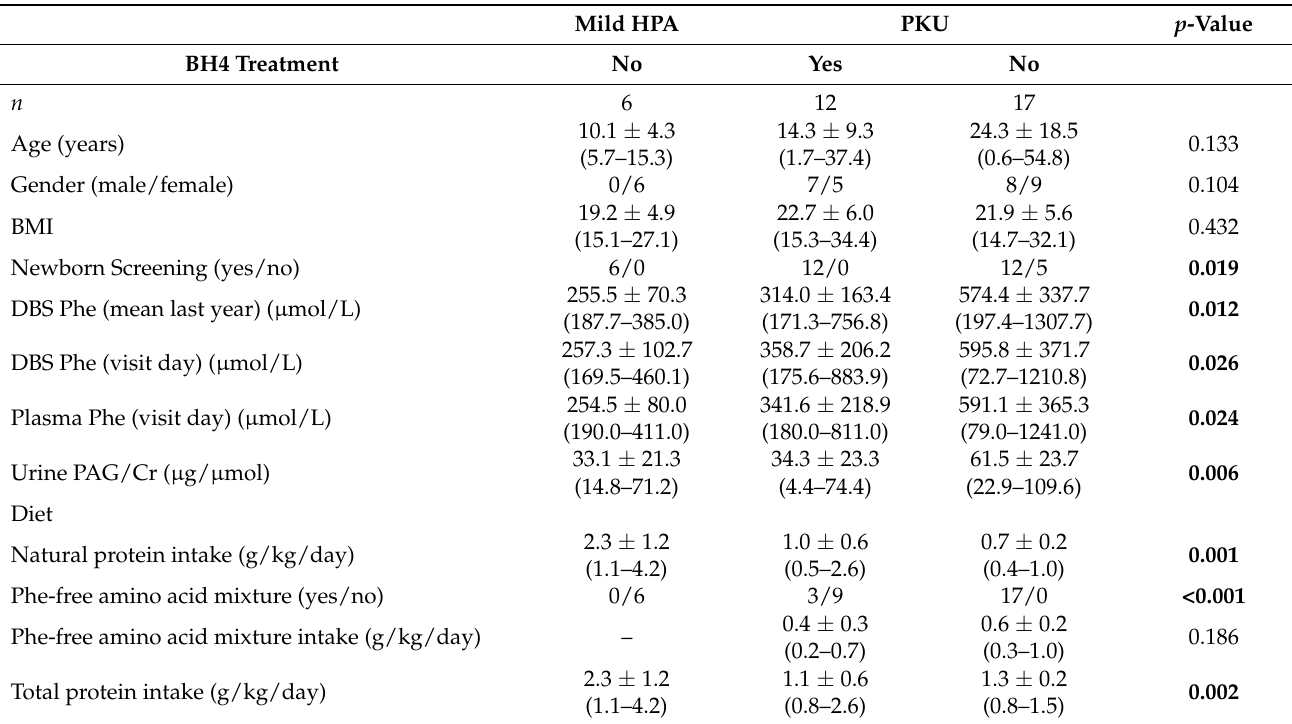
Significant p -values are marked in bold. Continuous variables are represented as mean ± standard deviation and range. Mild hyperpheny- lalaninemia (mHPA), phenylketonuria (PKU), body mass index (BMI), dried blood spot (DBS), phenylalanine (Phe), phenylacetylglutamine (PAG), creatinine (Cr).